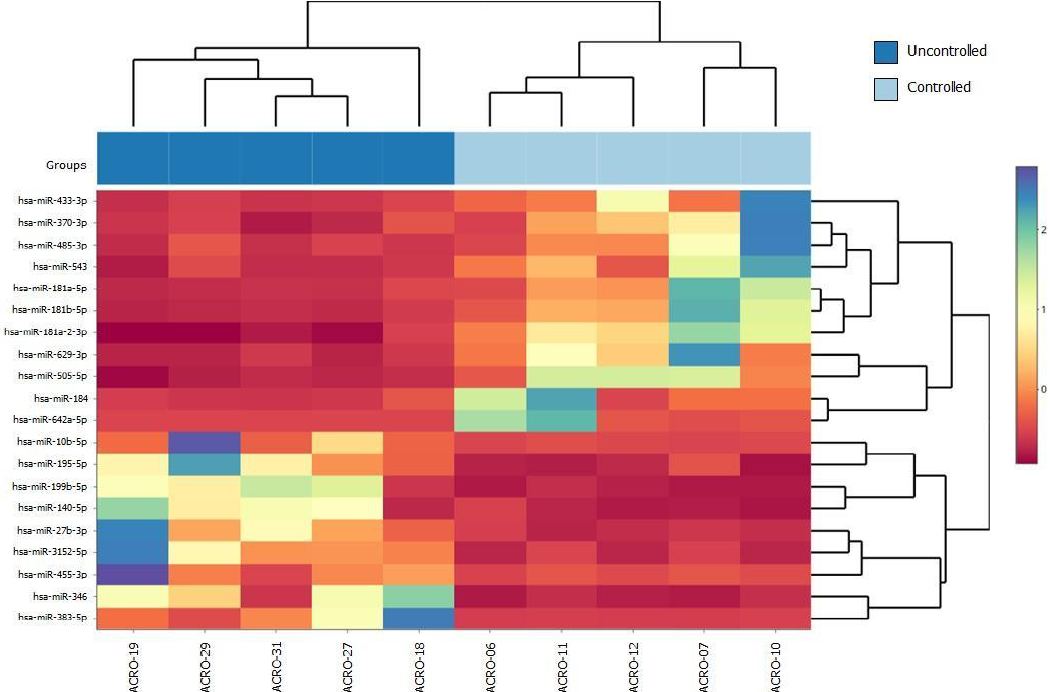
Figure 1. Heatmap of the top 20 differentially expressed miRNAs between the controlled and uncontrolled groups. The heatmap shows miRNA expression in each sample through the contrast of colors. On the left, the top 20 differentially expressed miRNA are depicted and clustered randomly according to their expression (clustering tree in the right); representative colors were used to identify expression (red is underexpressed; blue is overexpressed). On the bottom, the patients are displayed, and on the top, grouped samples appear according to their miRNA expression (light blue is controlled; dark blue is uncontrolled). hsa: Homo sapiens; miR: microRNA.